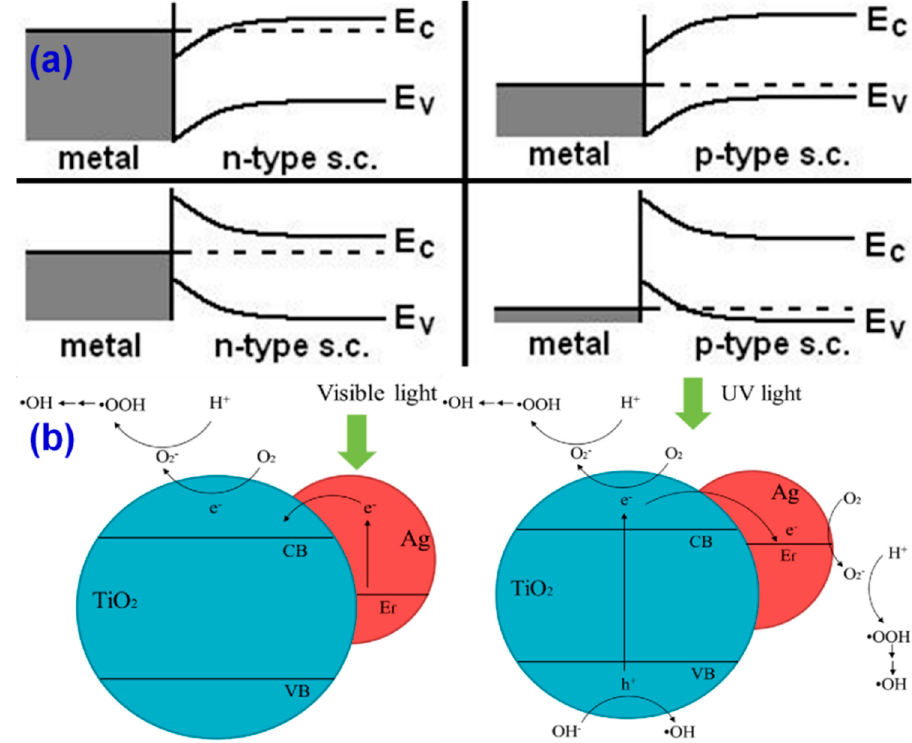
Figure 9. ( a ) Band bending occurs in the metal-semiconductor junction and ( b ) charge transfers in plasmonic photocatalyst, depending upon the light source irradiated (reproduced with permission from refs. [134,138],